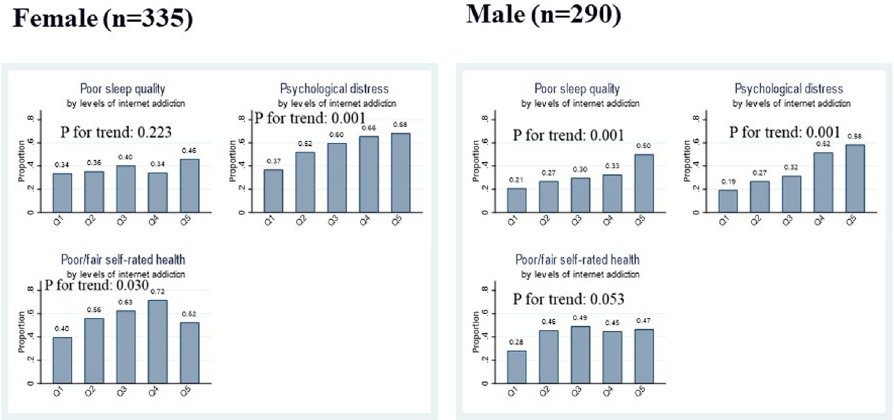
Fig 2. Gender-specific distributions of poor sleep quality, psychological distress, and poor/fair self-rated health by levels of internet addiction (Q:quintile).